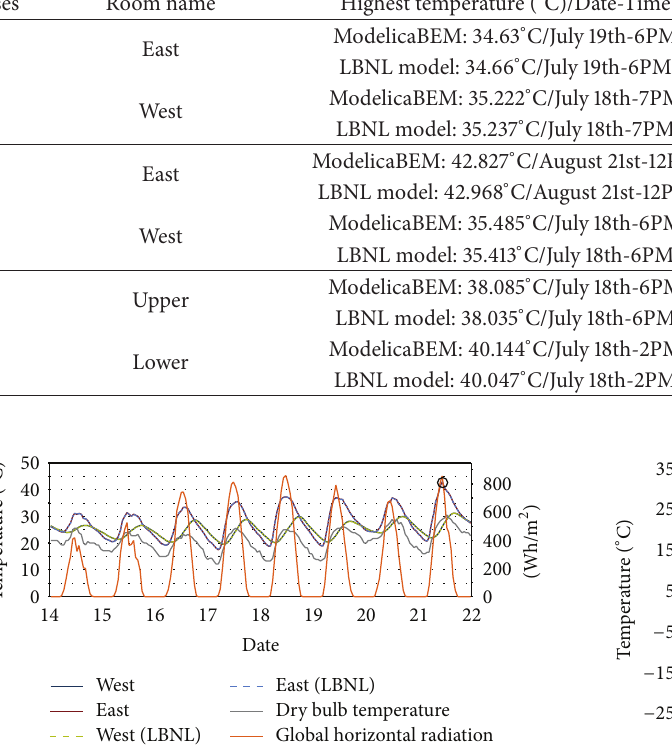
Figure 13: Temperature comparison of Test Case 2 for August 14th to 22nd. Solid circle (12PM, August 21st) points out the highest temperatures of the East Room. The temperature curves overlap between the two models.